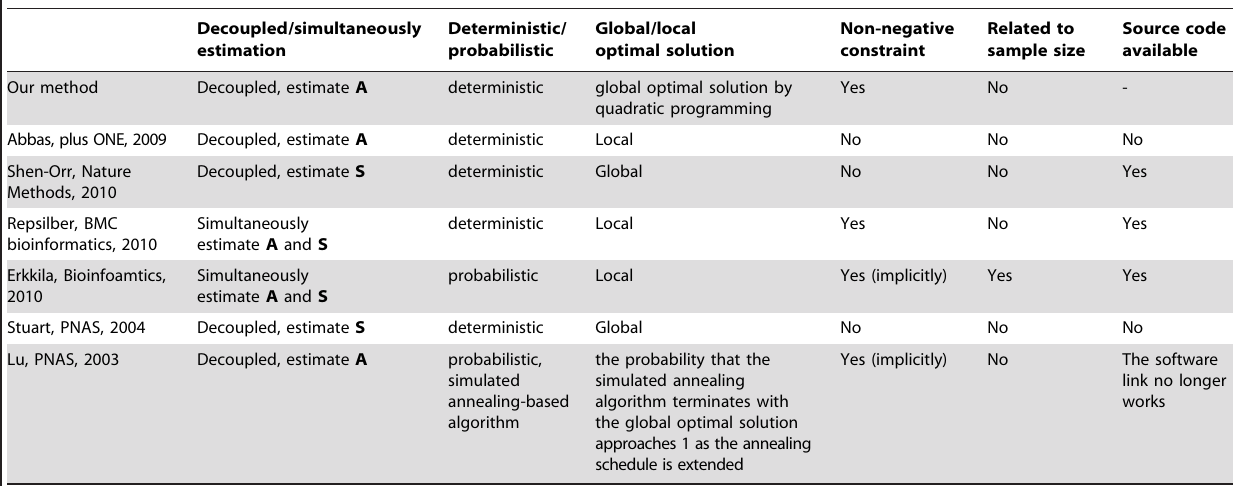
Table 2. Summary of current major deconvolution methods.